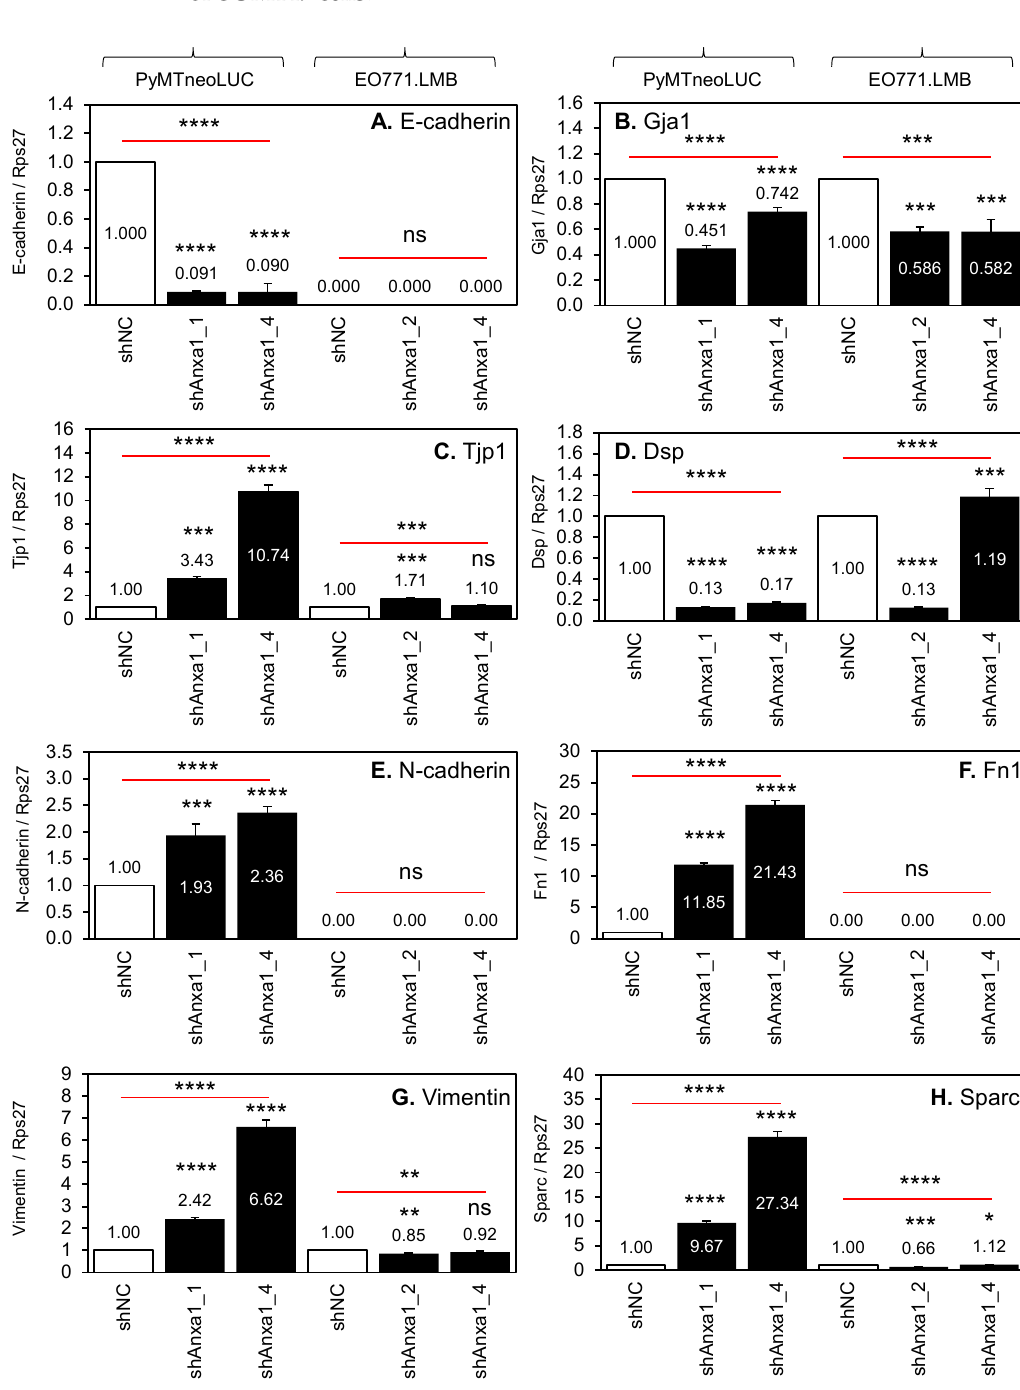
Figure 5. Expression of epithelial and mesenchymal markers in mouse mammary tumor cell lines harboring Annexin A1 knockdown qRT-PCR analysis was conducted on the indicated cell lines as described in the Materials and Methods. Gene expression was normalized to Rps27 levels and mRNA levels of genes of interest was set to 1 in control PyMTneoLUC_shNC and EO771.LMB_shNC cell lines. ( A – D ) Epithelial markers. ( E – H ) Mesenchymal markers. ( A ) E-cadherin. ( B ) Gja1. ( C ) Tjp1. ( D ) Dsp. ( E ) N-cadherin. ( F ) Fibronectin (Fn). ( G ) Vimentin. ( H ) Sparc/osteonectin. Mean ± SD ( n = 3). Data were analyzed using one-way ANOVA followed by Dunnett’s post hoc test for multiple comparisons to compare to con- trol shNC cells *, p < 0.05. **, p < 0.01. ***, p < 0.001. ****, p < 0.0001. ns (not significant). With regard to markers of mammary epithelial cell lineage, both of the PyMTneo- LUC_shAnxa1 lines had almost completely lost expression of luminal cytokeratin 8 (K8)